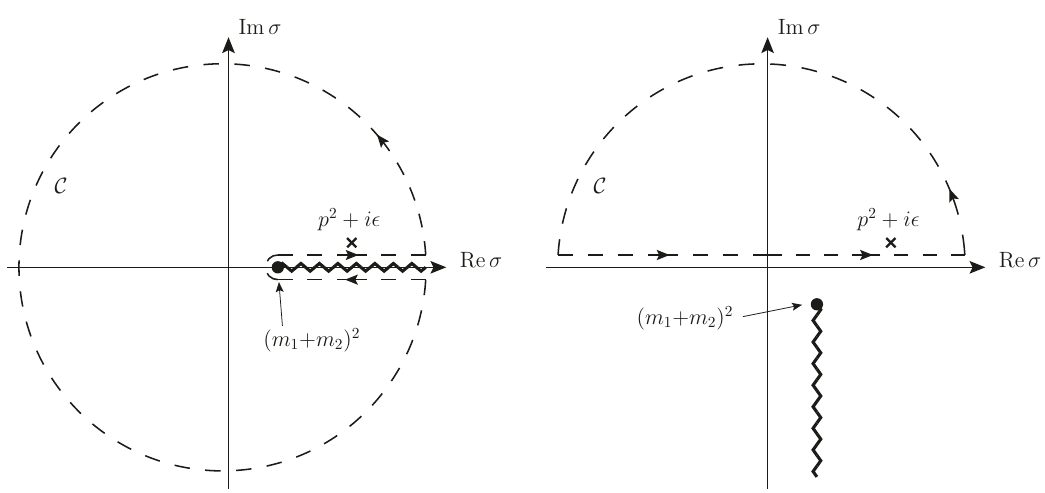
, m 2 > 0 (left) and m 2 < 0 , m 2 > 0 (right). The zigzag lines denote 1 2 1 2